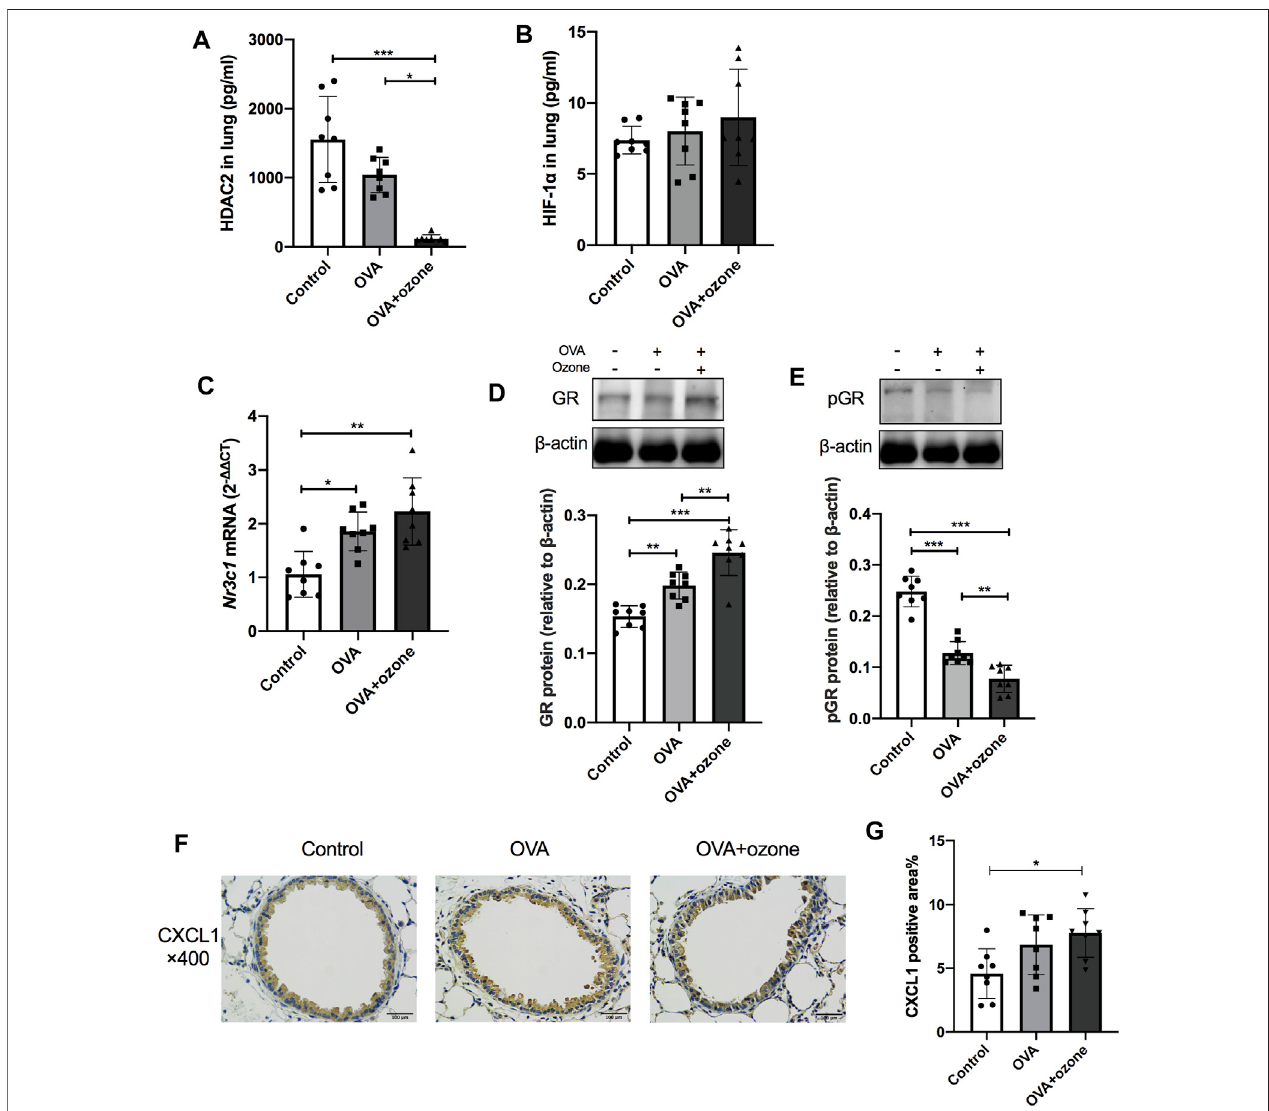
FIGURE 3 | Expression of cytokines and receptors related to corticosteroid resistance in the lung tissue of mice suffering from asthma. The expression of HDAC2 and HIF-1 α inthelungtissueofmice wasmeasured byELISAs. Nr3c1 (geneofGRs)mRNAwasdetected byRT-qPCR.Theexpression ofGRproteinand p-GRprotein was measured by western blotting. (A) HDAC2 expression in lung tissue. (B) HIF-1 α expression in lung tissue. (C) Expression of Nr3c1 mRNA in lung tissue. (D) Expression ofGR protein in lung tissue. (E) Expression of p-GR protein in lung tissue. (F) Representative photomicrographs of immunohistochemistry of CXCL1 in lung-tissue slices. (G) Percent CXCL1-positive area around airways. CXCL1, chemokine (C-X-C motif) ligand 1; GR, glucocorticoid receptor; HDAC2, histone deacetylase 2; p-GR, phosphorylated-GR. * p < 0.05; ** p < 0.01; *** p < 0.001.